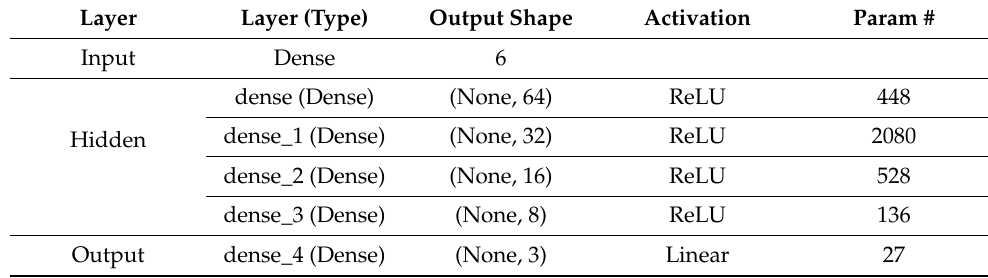
Table 8. Network architecture of MIG welding